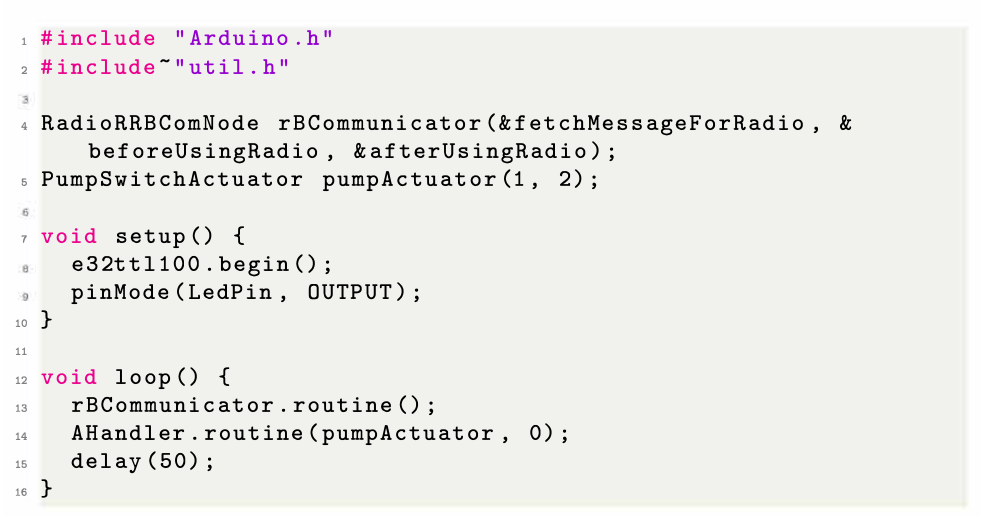
Figure 13. Control subsystem using our framework. The user needs fewer than 20 lines of code to obtain a working subsystem with all the advantages provided by the